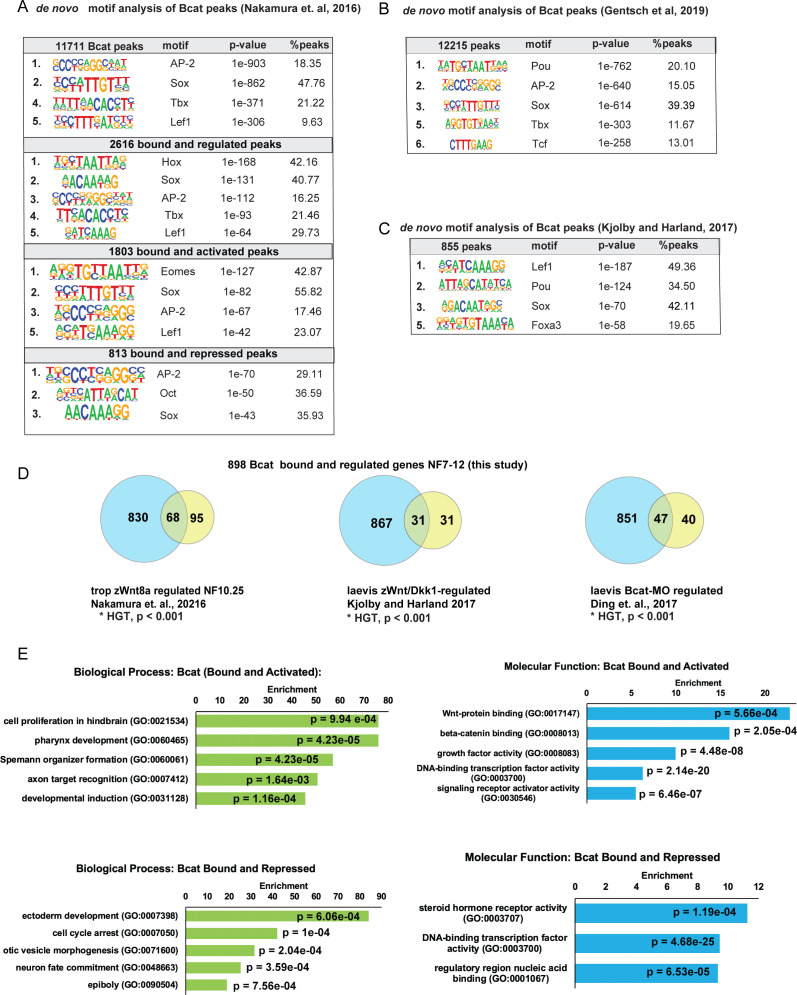
Additional analysis of Bcat ChIP-Seq.(A) De-novo motif analysis of Bcat peaks associated with different groups of Bcat-regulated genes, based on HOMER hypergeometric test. X. tropicalis stage 10.5 gastrula Bcat ChIP-Seq dataset from GSE72657 (Nakamura et al., 2016). (B) De-novo motif analysis of Bcat-bound peaks from St.10+ Bcat ChIP-Seq data from Gentsch et al., 2019. (C) And of Bcat-3xFlag ChIP-Seq peaks from X. laevis stage 11.5 gastrula from GSE77365, Kjolby and Harland, 2017; show a similar enrichment of SOX motifs based on HOMER hypergeometric test. (D) Comparison of differentially expressed Bcat-regulated genes in this study with other recent genomic analysis of gastrula-stage Wnt targets (Ding et al., 2017; Nakamura et al., 2016; Kjolby and Harland, 2017) shows significant overlap, *p<0.001 by hypergeometric enrichment test. (E) GO enrichment analysis of Bcat-bound and -regulated genes bases on Fisher’s exact test with p-values adjusted to 5% FDR for multiple testing correction.